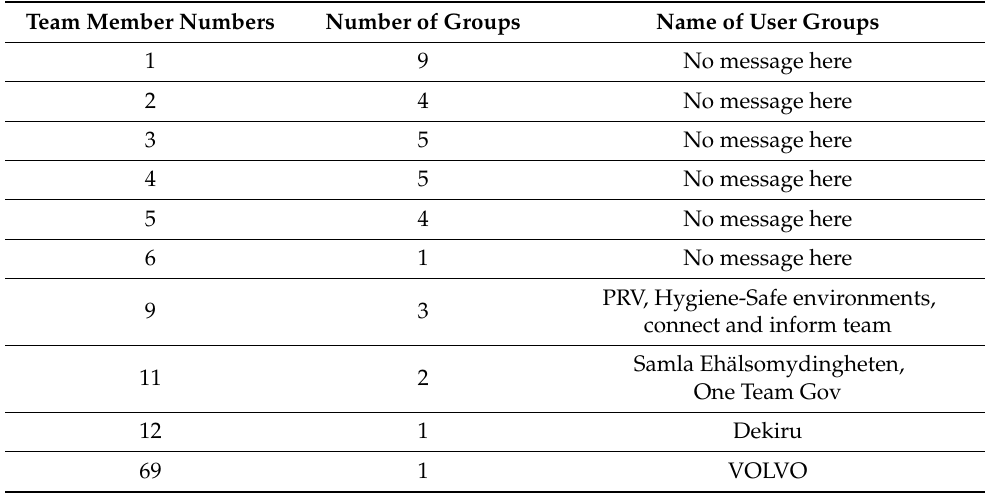
Table A1. Teams. Groups that did not have any chat or single chat by the creator are not listed Table A1. Team Member